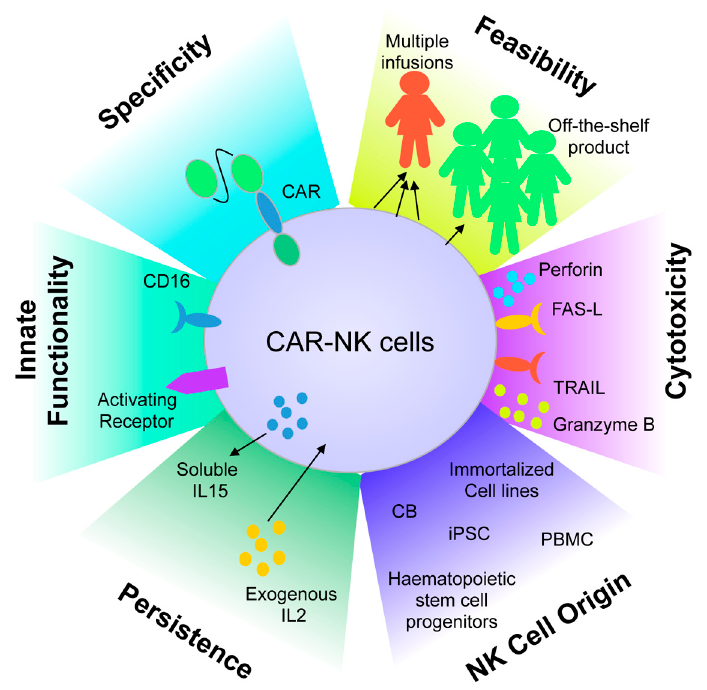
Figure 3. Benefits of chimeric antigen receptor-natural killer (CAR-NK) cells. NK cells of different origin can be genetically modified through the use of CAR constructs able to redirect their specificity against antigens expressed on tumor cells. These NK cells can be further expanded ex vivo to reach clinically meaningful numbers, and further optimized by the activation of their native receptors, including CD16 for the antibody dependent cell-mediated cytotoxicity (ADCC) mechanism. CB, cord blood; iPSC, induced pluripotent stem cells; PBMC, peripheral blood mononuclear cells; FAS-L, FAS-ligand; IL2, interleukin-2; IL15, interleukin-15; TRAIL, tumor necrosis factor (TNF)–related apoptosis-inducing ligand.